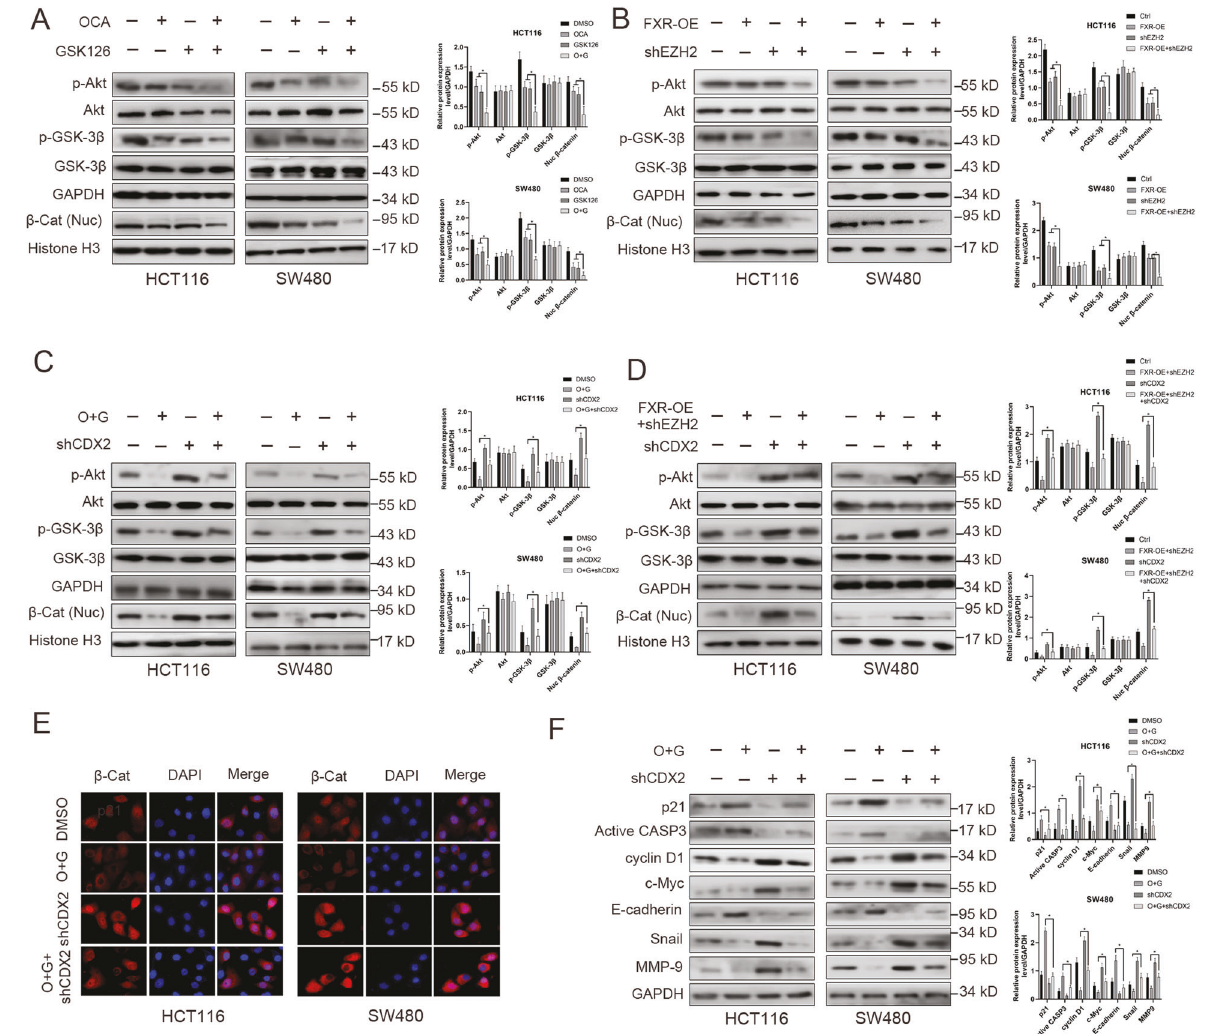
Fig. 5 The combination of OCA and GSK126 synergistically accelerated FXR nuclear localization and promoted CDX2 expression and its regulated signaling pathways. a The protein levels of AKT/p-AKT (Ser473), GSK-3 β /p-GSK-3 β (Ser9), and β -Catenin (Nuclear) in HCT116 and SW480 cells treated with OCA and GSK126 alone or in combination by western blotting analysis (left panel: gel bands; right panel: quantitative analysis of these proteins). b The protein levels of AKT/p-AKT (Ser473), GSK-3 β /p-GSK-3 β (Ser9) and β -Catenin (Nuclear) in HCT116 and SW480 cells with FXR overexpression, EZH2 depletion alone or in combination by western blotting analysis (left panel: gel bands; right panel: quantitative analysis of these proteins). c , d The effect of CDX2 depletion on the he protein levels of AKT/p-AKT (Ser473), GSK-3 β /p-GSK-3 β (Ser9), and β -Catenin (Nuclear) in HCT116 and SW480 with OCA and GSK126 combination ( c left panel: gel bands; right panel: quantitative analysis of these proteins) or FXR overexpression and EZH2 depletion ( d left panel: gel bands; right panel: quantitative analysis of these proteins). e The effect of OCA and GSK126 on the nuclear translocation of β -Catenin detected by IF staining. f The effect of CDX2 depletion on the protein levels of cell cycle-related, apoptosis-related, and EMT-related proteins in HCT116 and SW480 cells treated with OCA and GSK126 alone or in combination by western blotting analysis (left panel: gel bands; right panel: quantitative analysis of these proteins). All data are the mean ± SD of three independent experiments. * P <